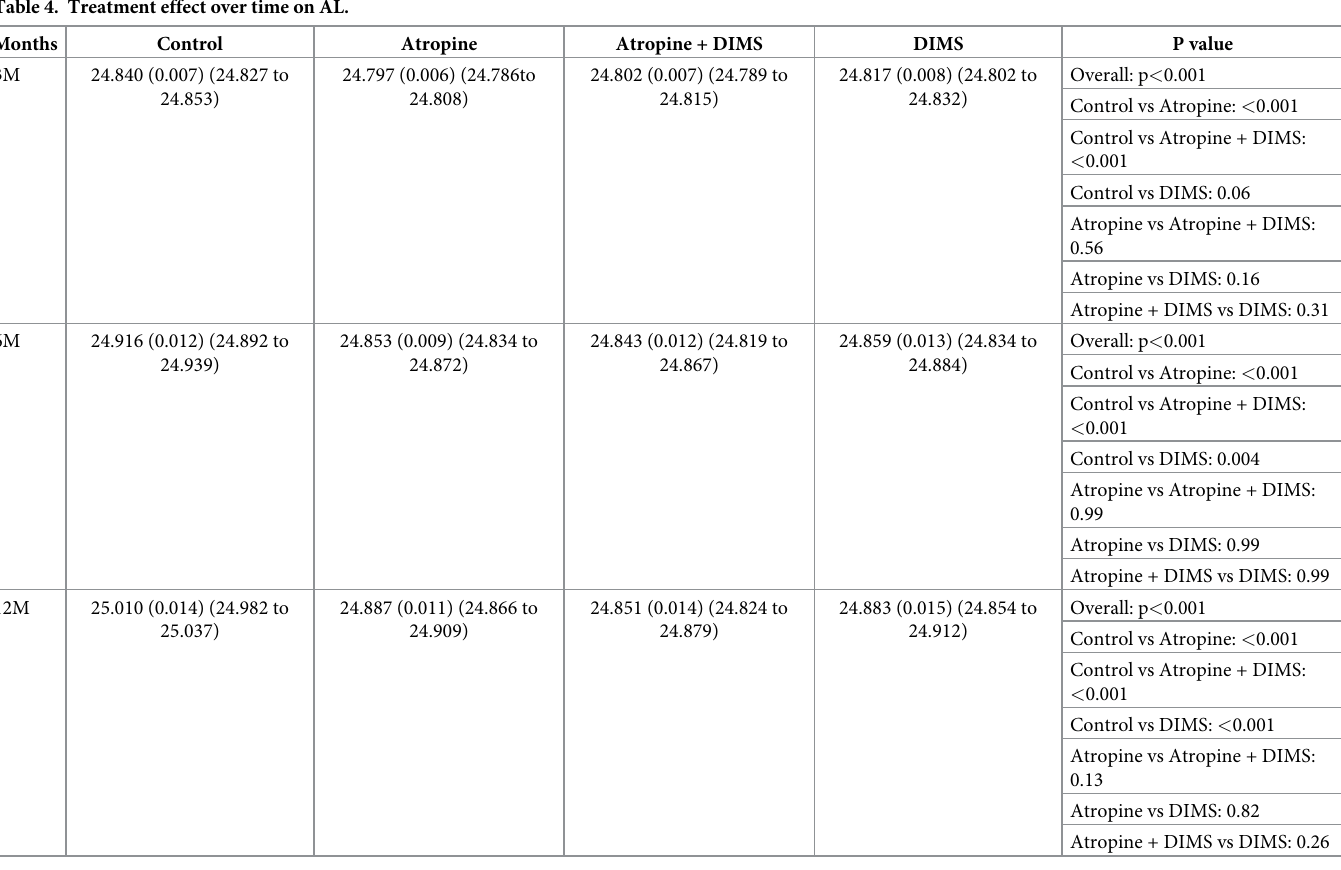
Table 4. Treatment effect over time on